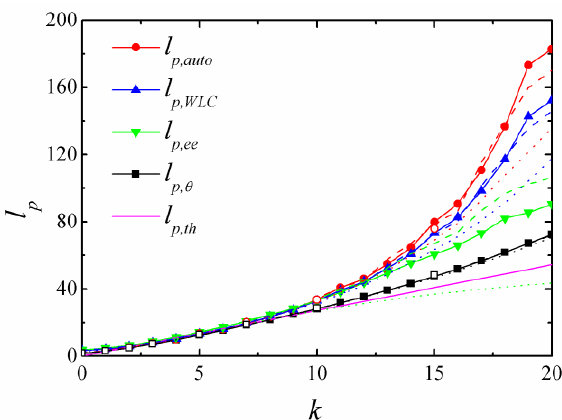
Figure 4. The persistence lengths as a function of bending constant k. l p,auto , l p,WLC , l p,ee and l p,θ are persistence lengths calculated according to the orientation correlation function, the mean square end- to-end distance of a worm-like chain, the projection of the end-to-end vector on the first bond and the bond angle, respectively. The contour length L of the chain is 136.